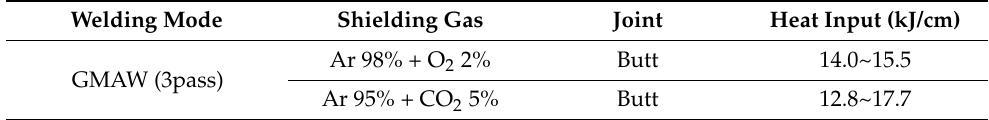
Table 3. Welding condition for determination of shielding gas.